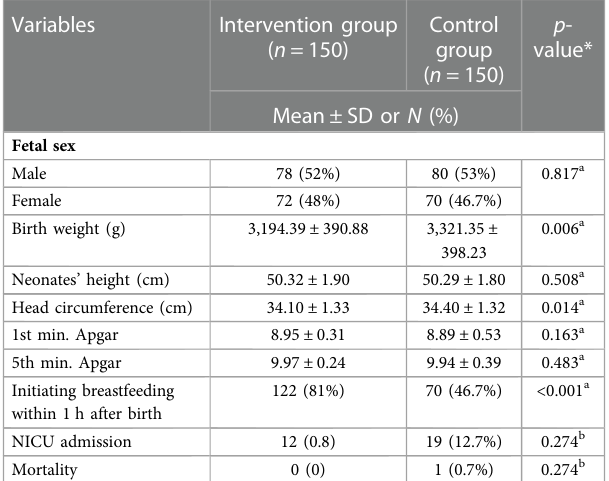
TABLE 4 Childbirth satisfaction and positive experience in intervention and control groups. Variables